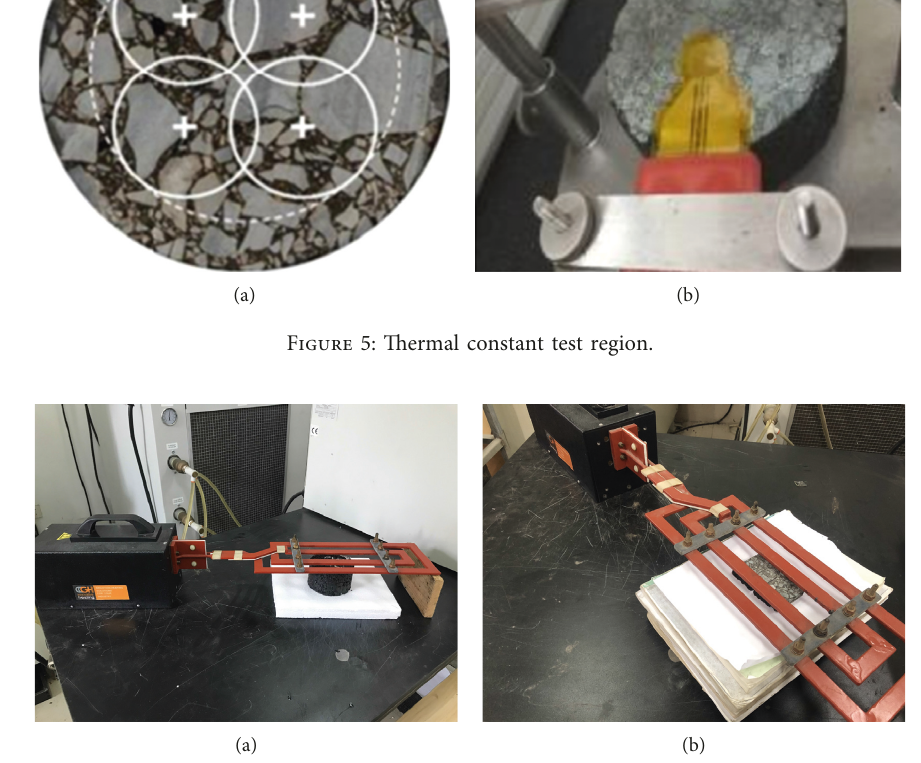
Figure 6: Experiment on (a) induction heating temperature and (b) induction healing.